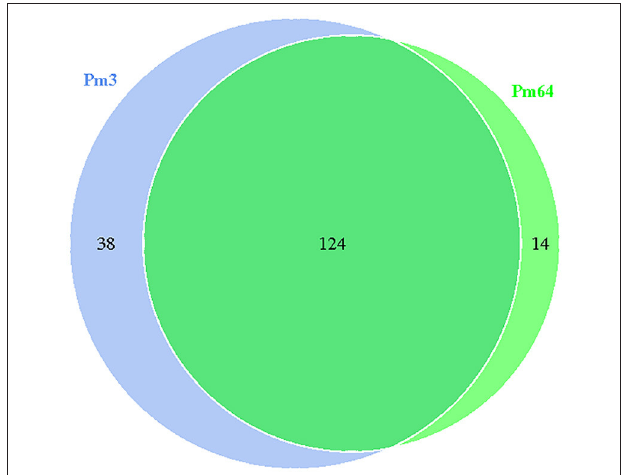
FIGURE 3 | Venn diagram of core and specific gene cluster of Pm3 and Pm64 gene islands. Each ellipse represents a sample, the data on each region represents the groups number occur in and only in the samples. A group represents a set of genes with more than 50% similarity and sequence length difference < 0.7.